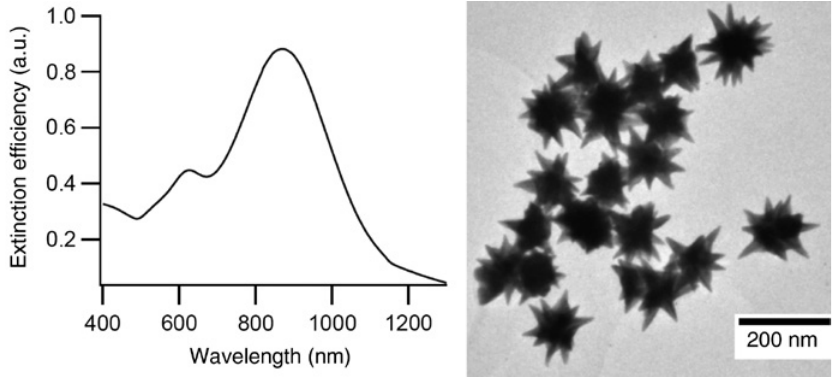
Figure 7: Left: Extinction spectrum of nanostars in solution. Right: TEM picture of gold nanostars. Reprinted from Ref. [24], Copyright IOP Publishing. Reproduced with permission. All rights reserved.